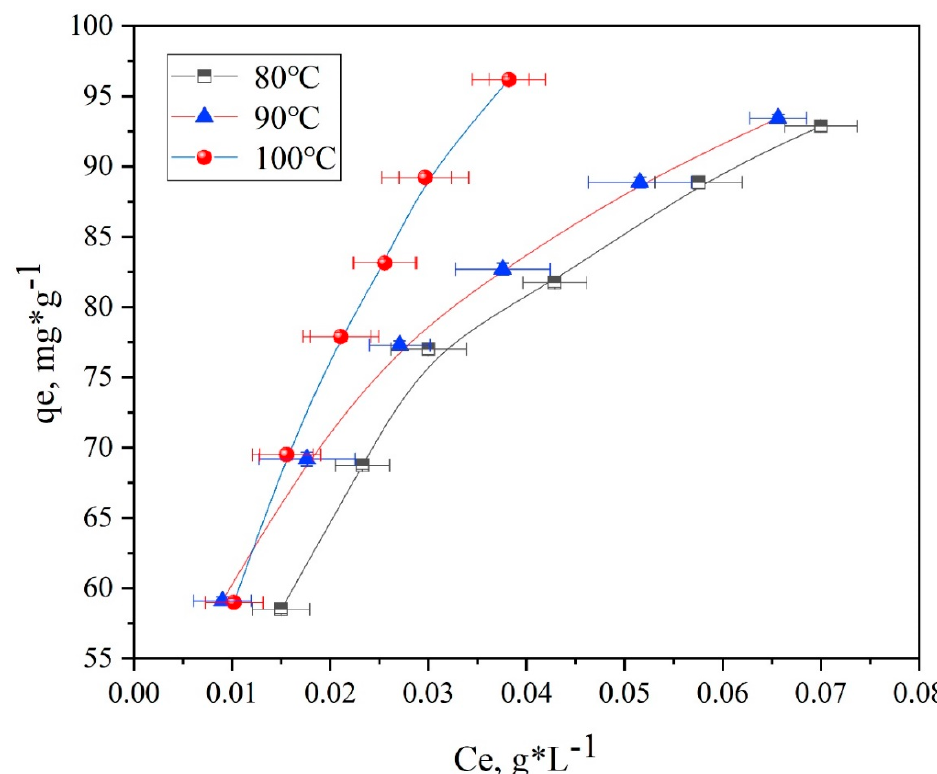
Figure 11. Adsorption isotherms of dyeable spandex dyed with neutral red G.